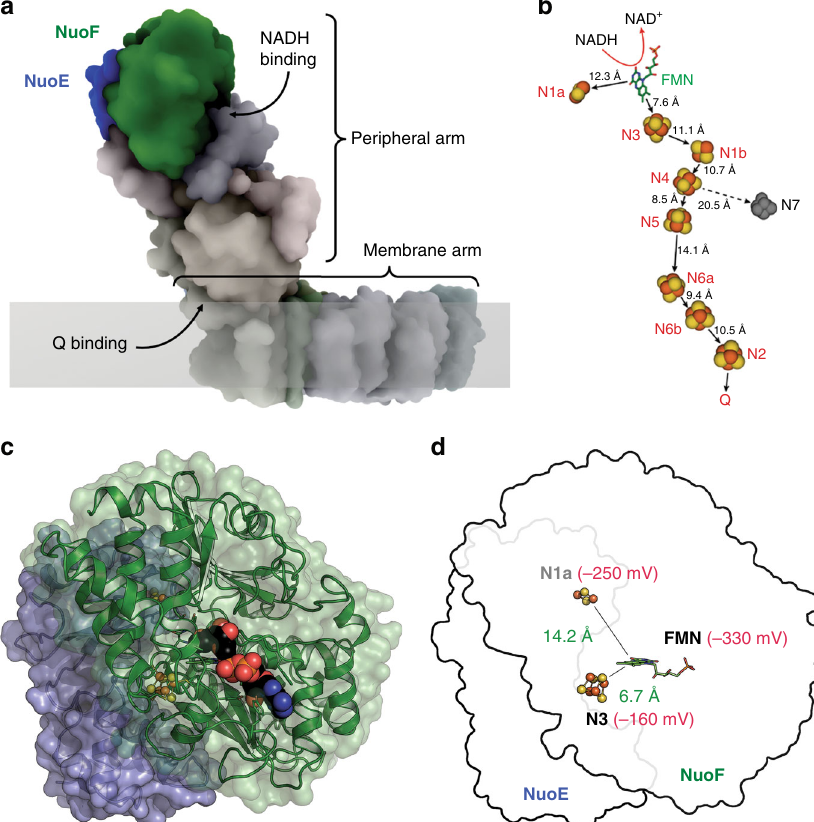
Fig. 1 The electron input module NuoEF of complex I. a Location of subunits NuoE and NuoF in respiratory complex I, at the apical end of the hydrophilic arm. The cartoon is based on the structure of the entire complex I from T. thermophilus (PDB code: 4HEA). b Schematic representation of the spatial arrangement of the cofactors in the peripheral arm of T. thermophilus complex I 24 . The Fe – S clusters involved in the electron transfer reaction are depicted in red/yellow and the edge to edge distance between the cofactors is provided in Å. The distance between N4 and N7 is too long to meet the physiological electron transfer rate. The distance between N2 and the quinone is under discussion. ( c ) Overall structure of the subcomplex NuoEF of Aquifex aeolicus complex I. NuoE (blue) is a two-domain protein of 18 kDa with an N-terminal α -helical domain, connected by a short linker sequence to a C-terminal domain with a thioredoxin fold that holds the [2Fe – 2S] cluster N1a. The 44 kDa subunit NuoF (green) consists of three domains, of which an antiparallel